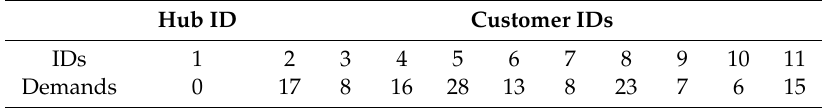
Table 2. Hub ID, Customer IDs and associated demands in example problem